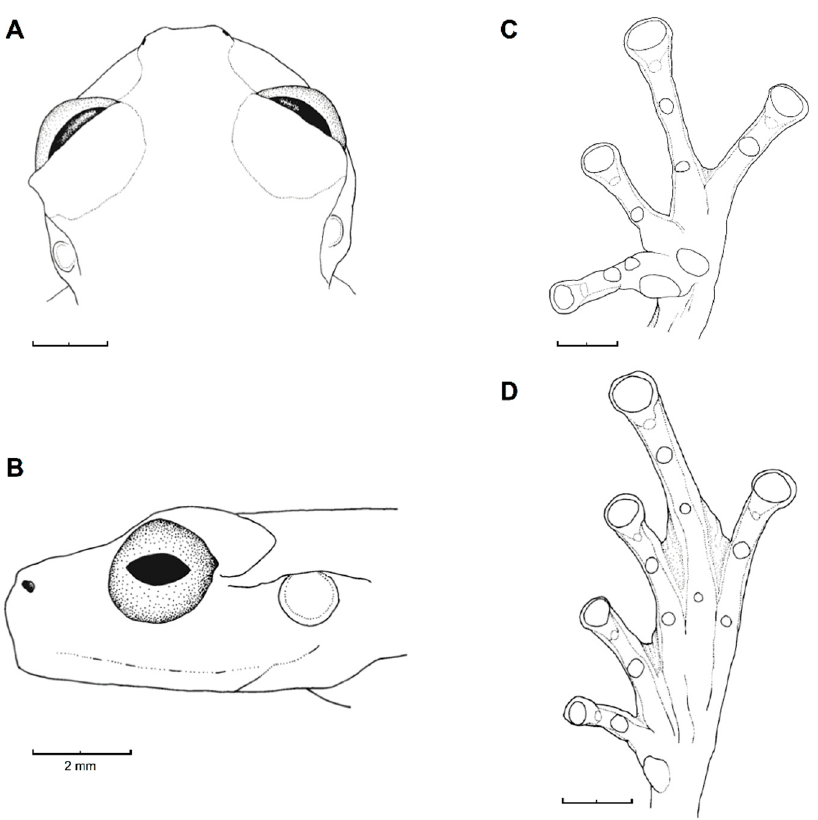
Figure 188. Nymphargus wileyi . ( A ) Head in dorsal view, QCAZ 26029. ( B ) Head in lateral view, QCAZ 26029. ( C ) Hand in ventral view, QCAZ 26028. ( D ) Foot in ventral view, QCAZ 26028. Modified from Guayasamin et al. [20].